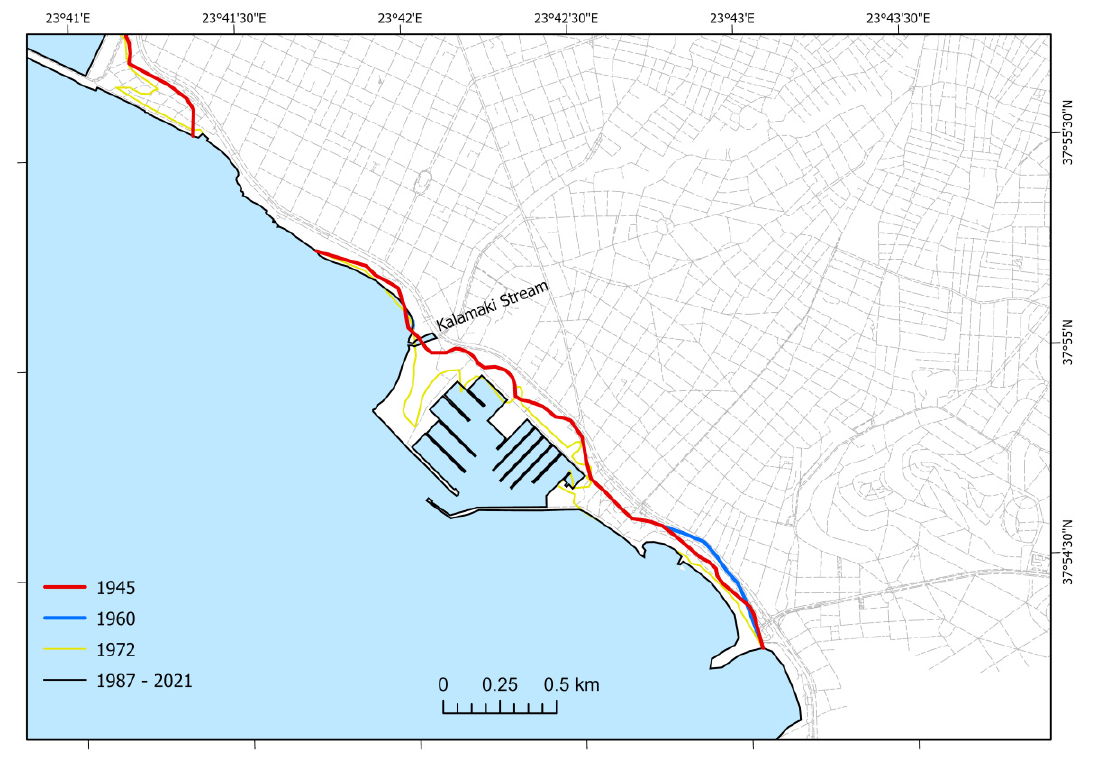
Figure 5. Changes of the Alimos coastline from 1945 to 2021.